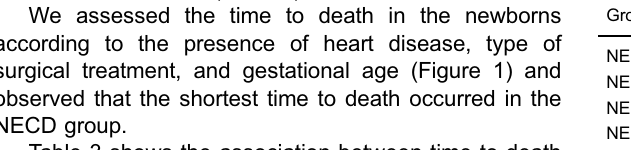
Table 3. Association between time to death and the groups in the non-survivor patients.